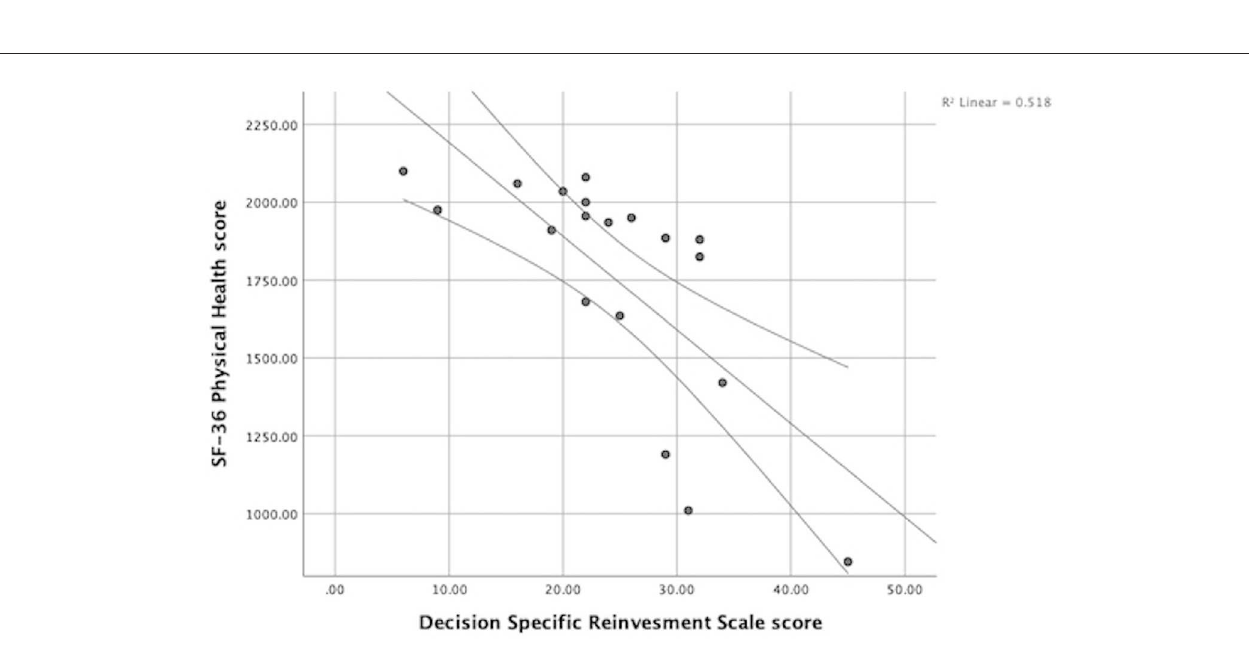
FIGURE4 Relation between SF-36 Physical Health score and Decision Specific Reinvestment scores. Athletes with better self-reported health (greater scores) had less tendency for